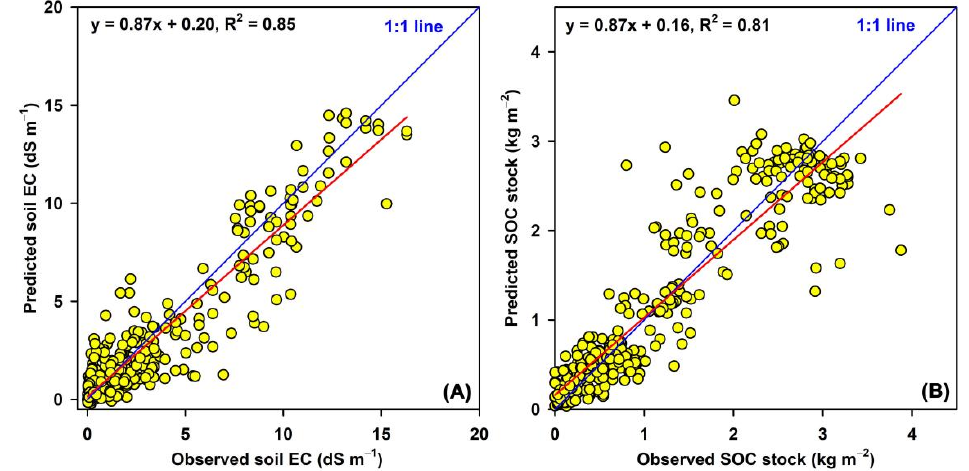
Figure 5. Comparison between observations and predictions for soil EC ( A ) and SOC stock ( B ) based on 30 runs of the 10-fold cross-validation procedures. Table 1. Performance of the XGBoost models in predicting soil EC and SOC stock.